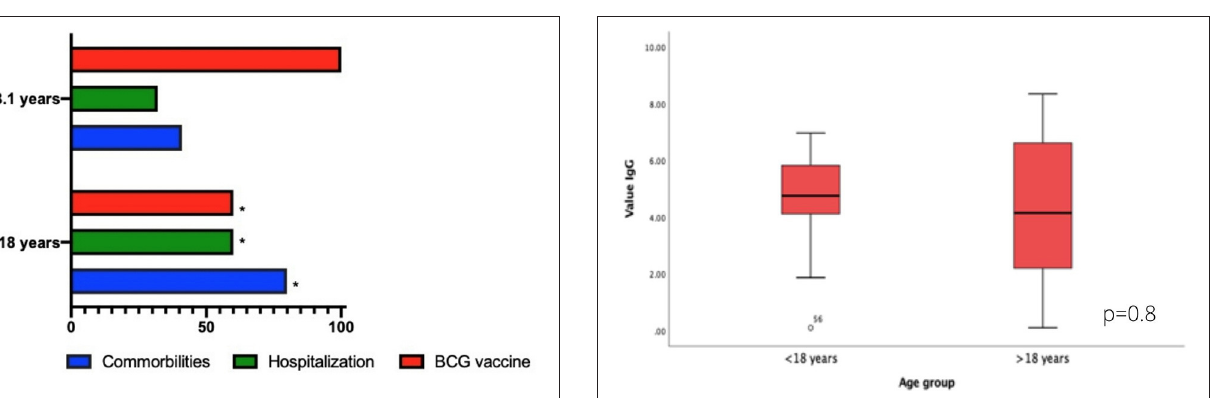
symptoms and the persistence of fever for more than 3 weeks ( Table 1 ).